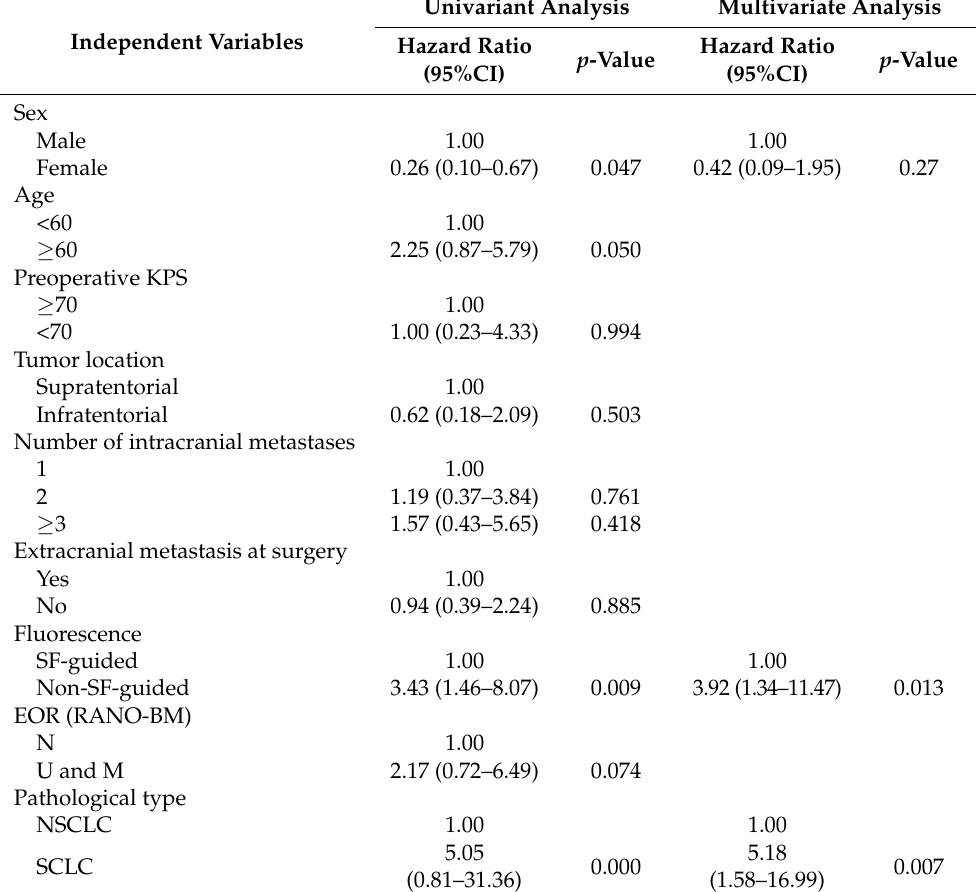
Table 3. Univariant and multivariate analysis for